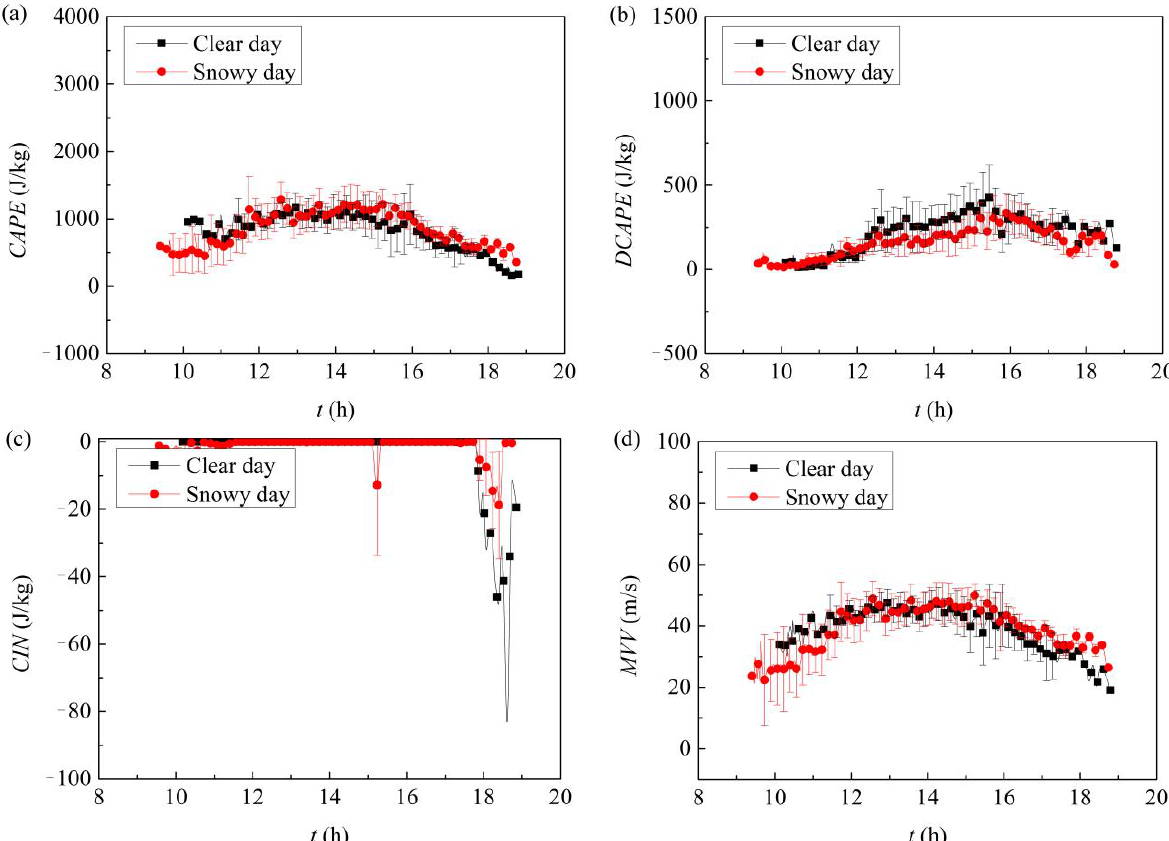
Figure 7. Statistical characteristics of stability indices (from 8:00 to 20:00 monsoon) season under different weather conditions. ( a ) CAPE , ( b ) D CAPE , ( c ) CIN , ( d ) MVV . The t (h) is expressed in UTC+8.